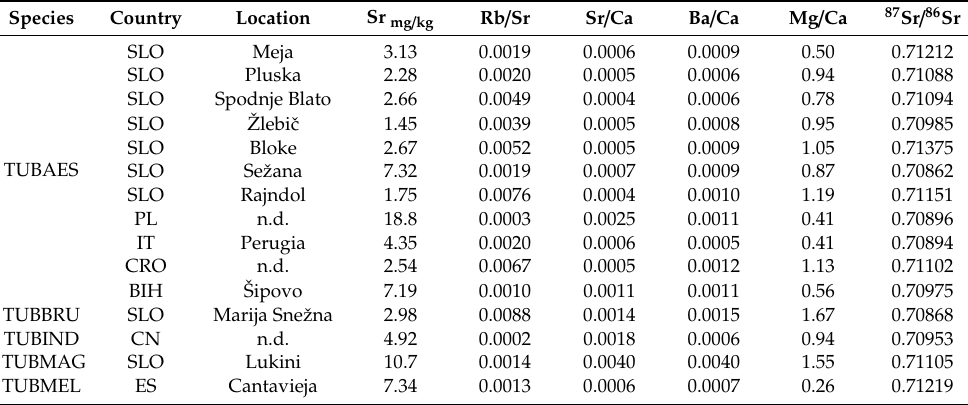
Table 2. Summary of the 87 Sr / 86 Sr rato data for tru ffl e species of di ff erent geographical origin, associated with local soil geology (Table S1, Supplementary Material), concentrations of Sr and molar ratios of Rb / Sr, Sr / Ca, Ba / Ca and Mg /